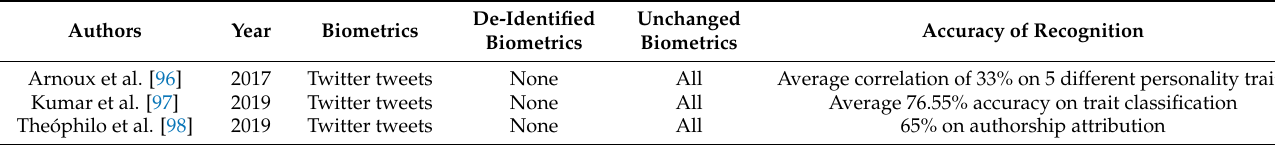
Table 8. Summary of psychological trait-based identification